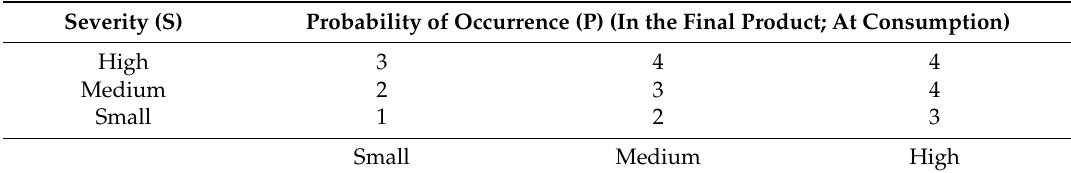
Table 10. Establish the risk class (RC).